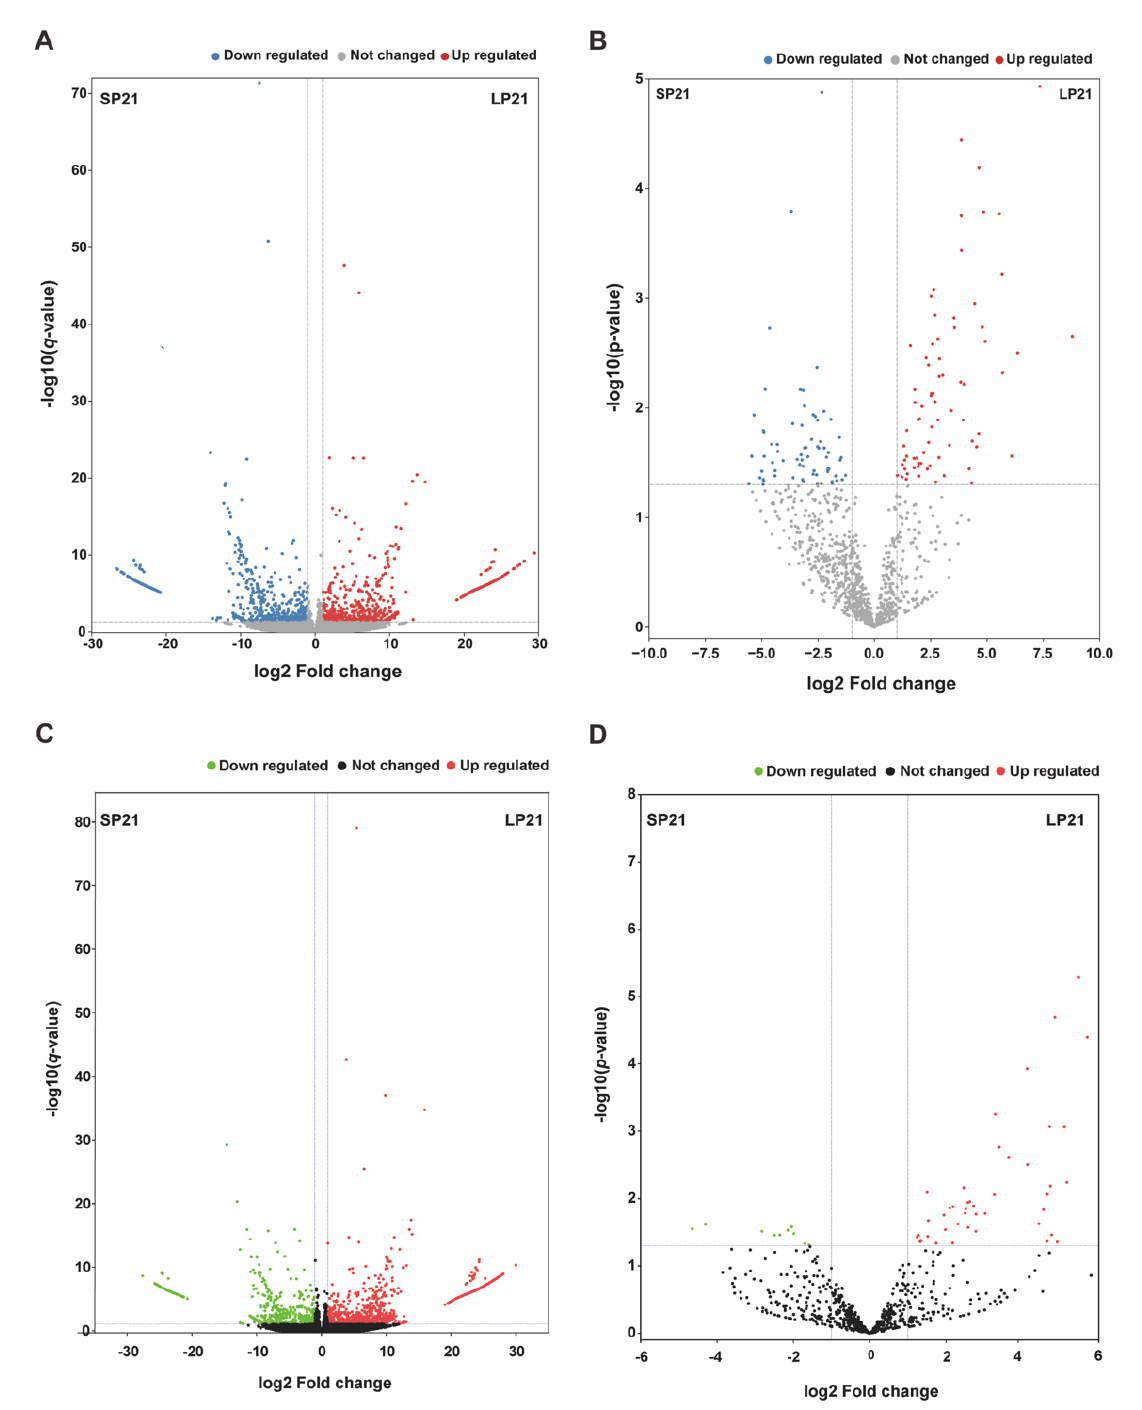
Figure 3. DEGs and DEMs analyses. Volcano plot of identified genes ( A ) and miRNAs ( B ) in SP21 − HYP vs. LP21 − HYP, where red and blue represent up or down-regulation, respectively. Volcano plot of identified genes ( C ) and miRNAs ( D ) in SP21 − PD vs. LP21 − PD, where red and green represent up or down-regulation,